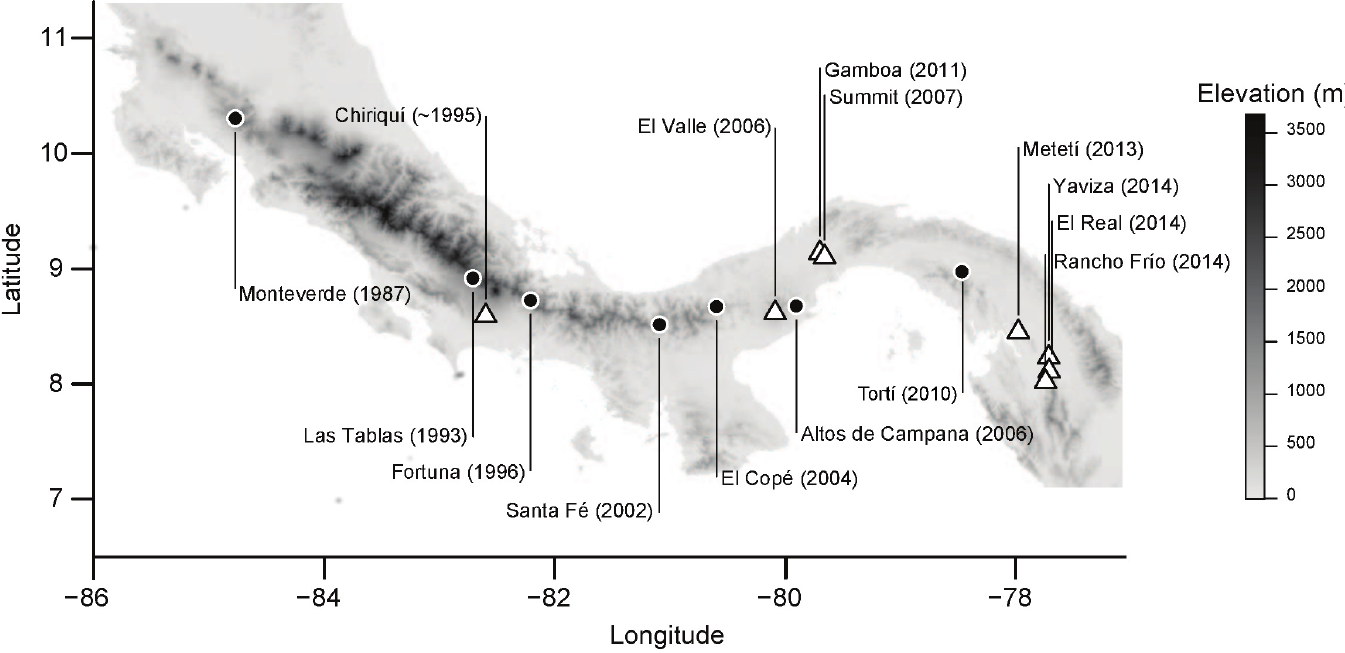
Fig 1. Sites where Bd has been detected in the past (filled circles), and sites where we sampled Túngara frog (Physalaemus [Engystomops] pustulosus) populations (open triangles). Year in parenthesis corresponds to year of decline or the year that Bd was first